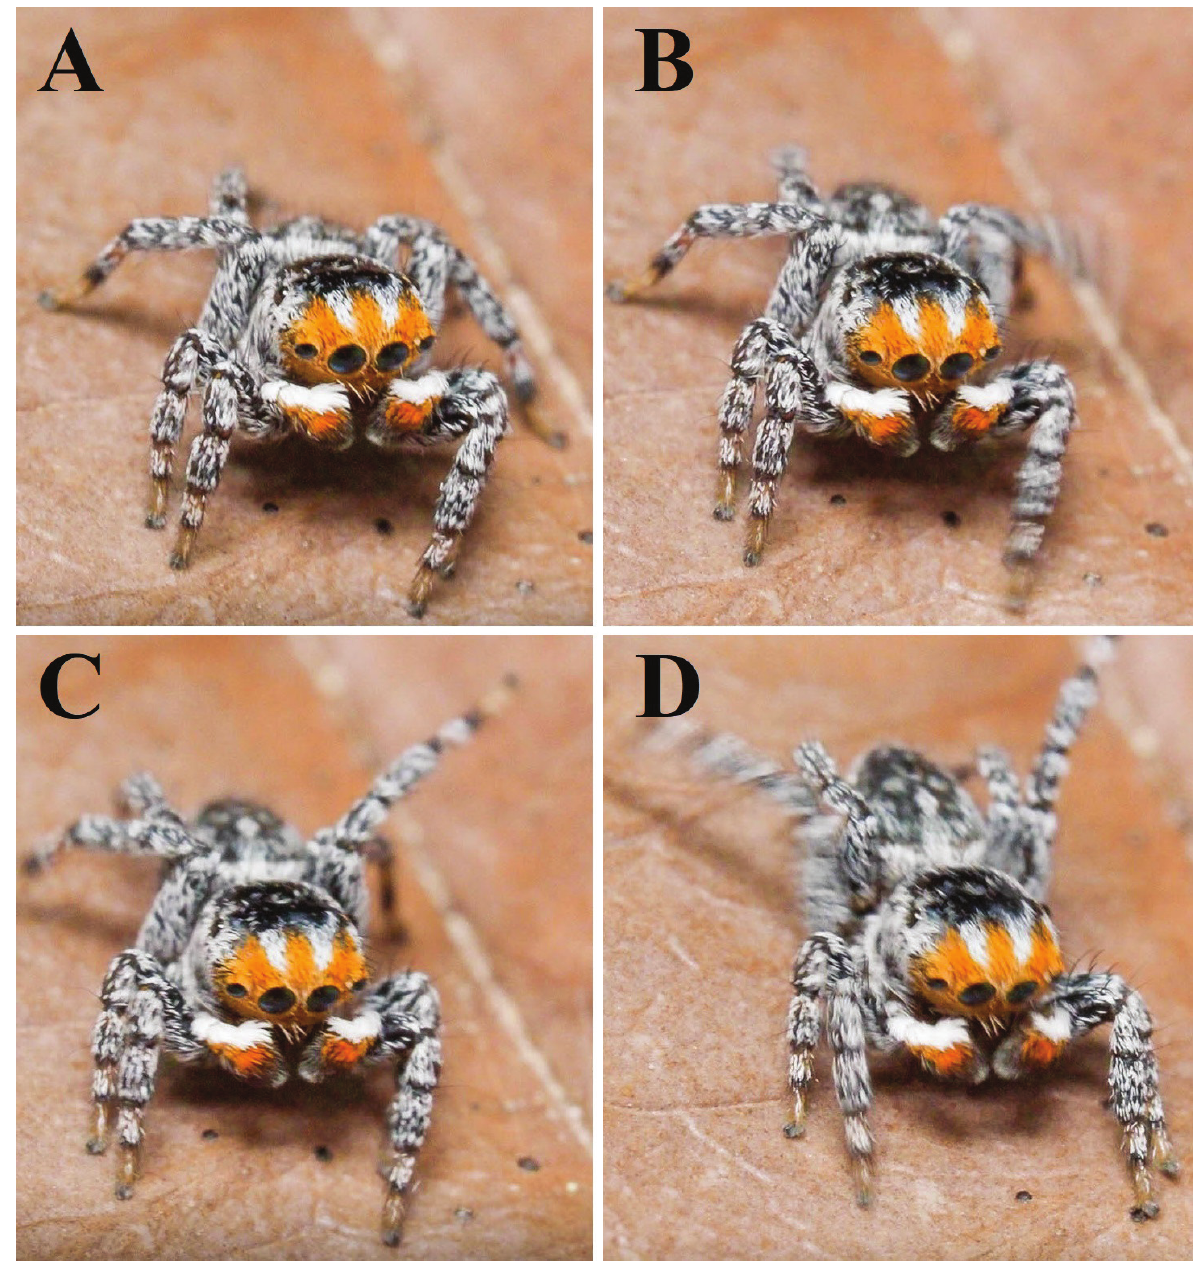
Figure 6. Sequential frames from a video of the courtship display of paratype male Maratus nemo sp. nov. (SAM NN30709) A stationary male focusing on a nearby female B left leg III extended and waved C left leg III extended and flexed and slow opisthosomal bobbing D both legs III extended and waved and opisthosoma is rapidly vibrated on the surface of the leaf creating an audible